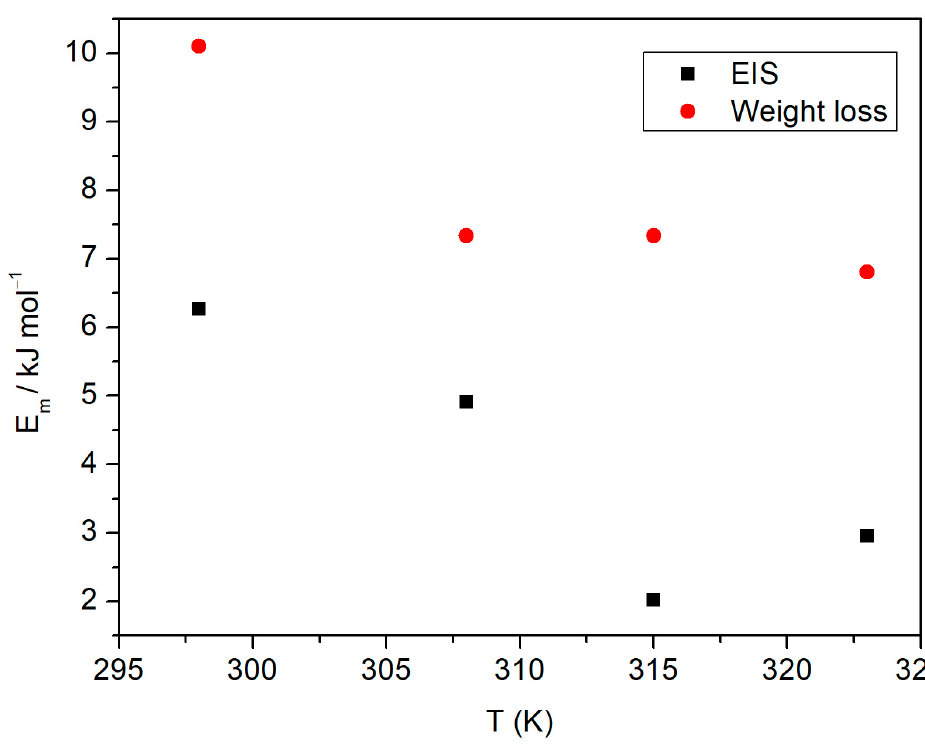
Figure 7. Adsorption energy vs. temperature of Ilex paraguariensis on aluminum.